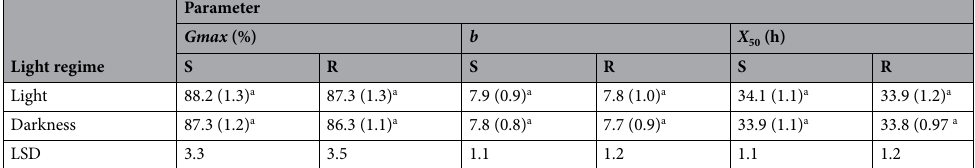
Table 6. Parameter estimates resulted from the fitting of three-parameter sigmoidal function to seed germination data associated with herbicide-resistant (R) and -susceptible (S) winter wild oat biotypes over time under light and darkness conditions. The values in parentheses denote standard error. Similar letters denote insignificant difference between the R and S biotype in each parameter. Gmax : maximum germination percentage; b : slope at X 50 ; X 50 : time to 50% of maximum germination at each temperature.